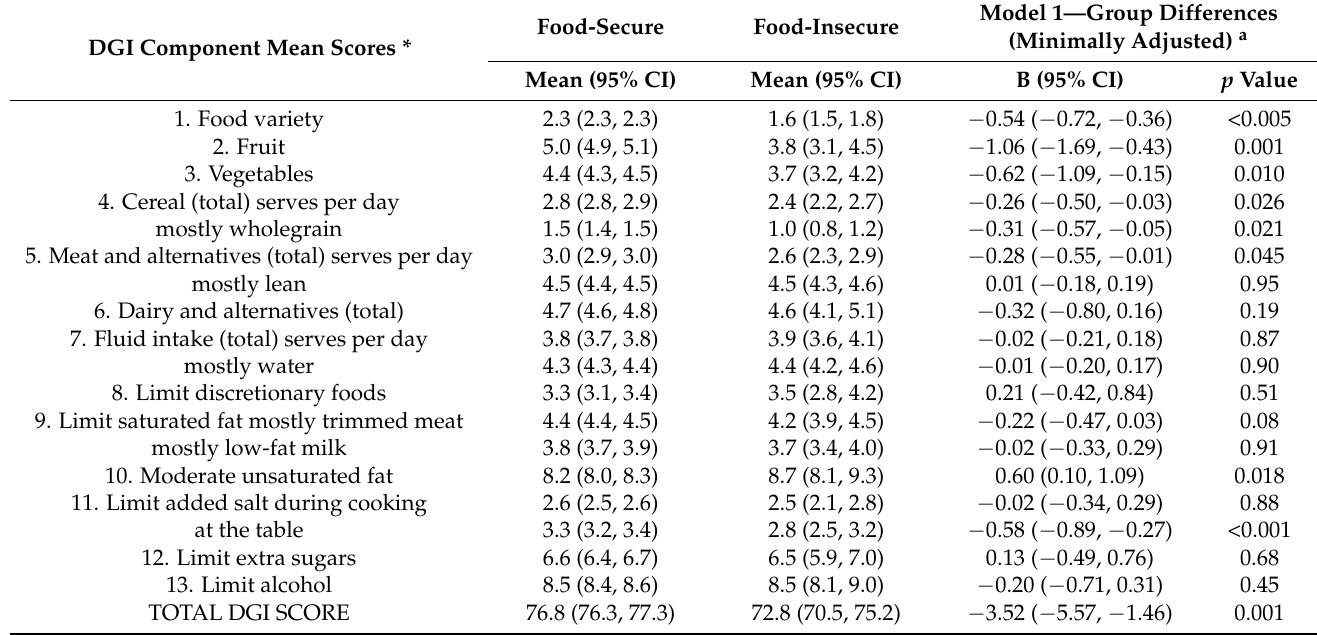
Table 2. DGI total and component scores by food security